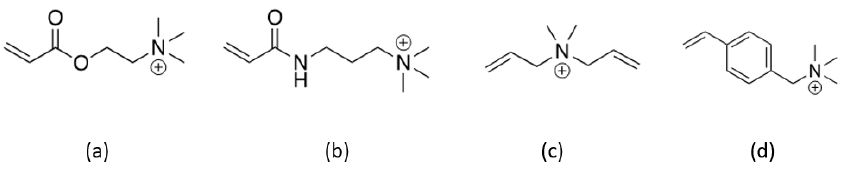
Figure 1. List of charged monomers used: ( a ) [2-(acryloyloxy)ethyl]trimethylammonium; ( b ) (3- acrylamidopropyl)trimethylammonium; ( c ) diallyldimethylammonium; ( d ) (vinylbenzyl)trime- thylammonium. All monomers have Cl − as a